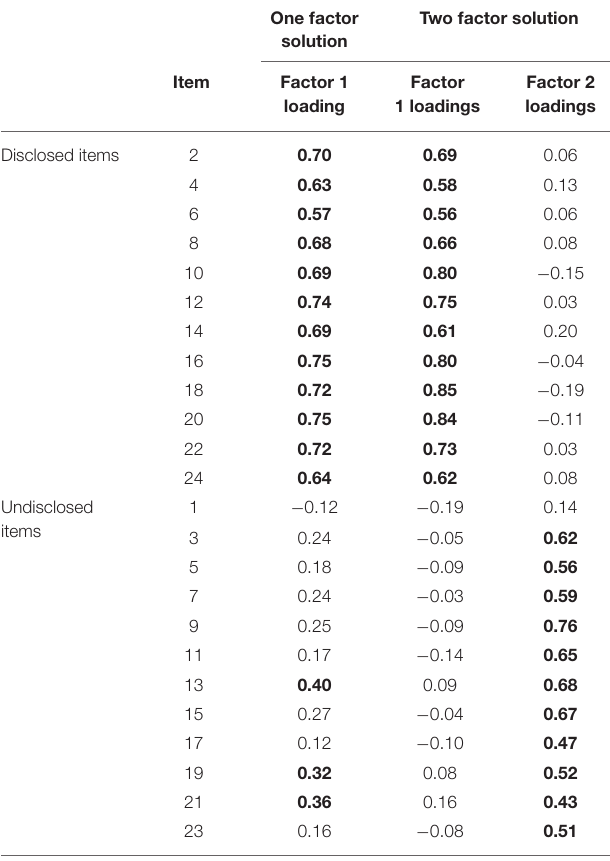
TABLE 4 | Factor loadings of conditional zRTs for